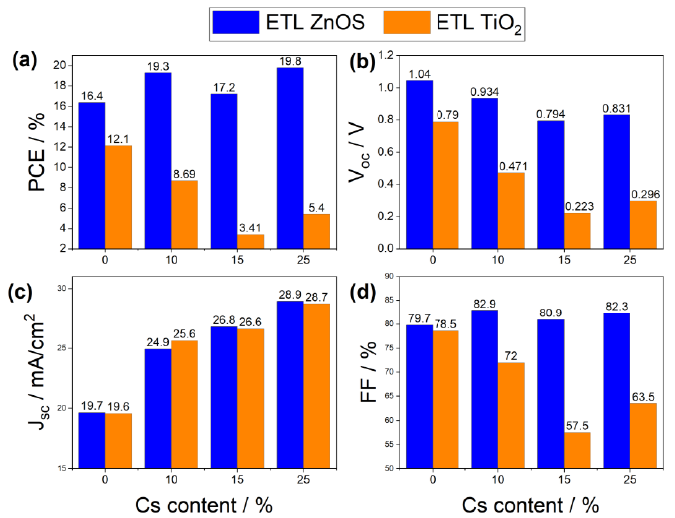
Figure 3. Behavior of ( a ) PCE , ( b ) V oc , ( c ) J sc , and ( d ) FF for absorber as a function of Cs content and different ETL materials; ZnOS is in blue and TiO 2 is in orange.